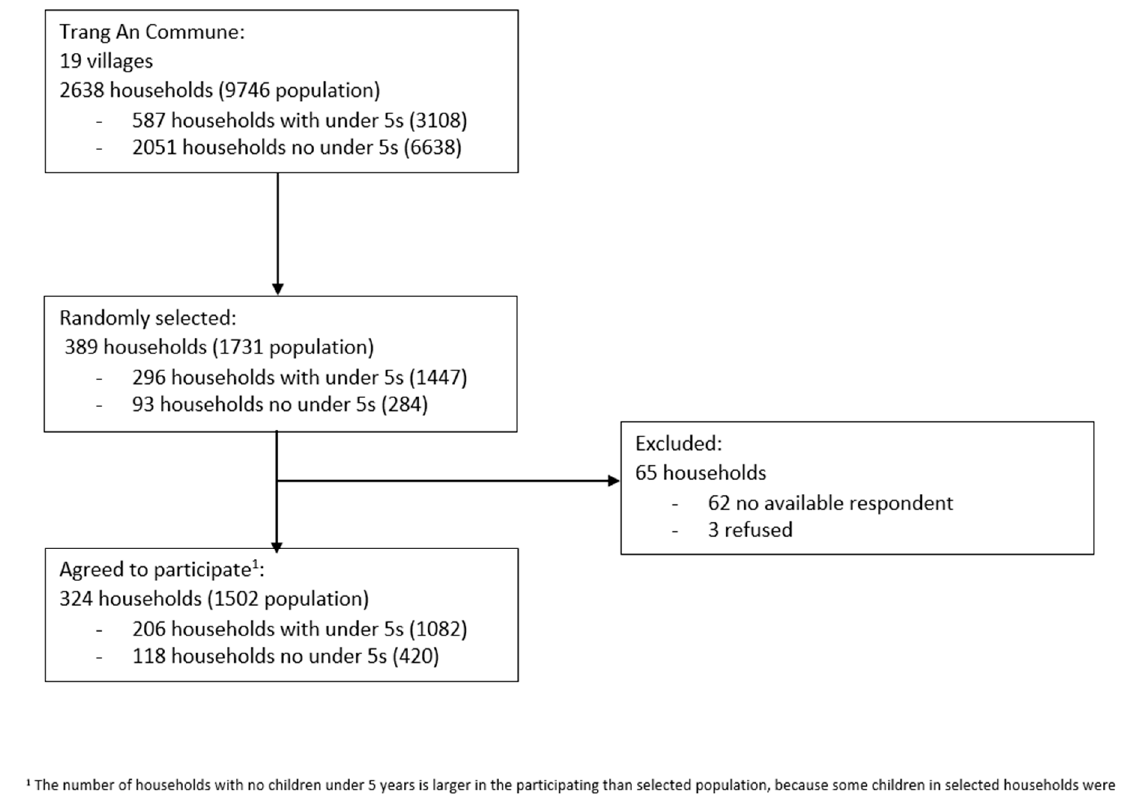
Figure 1. Flow diagram of participant inclusion.